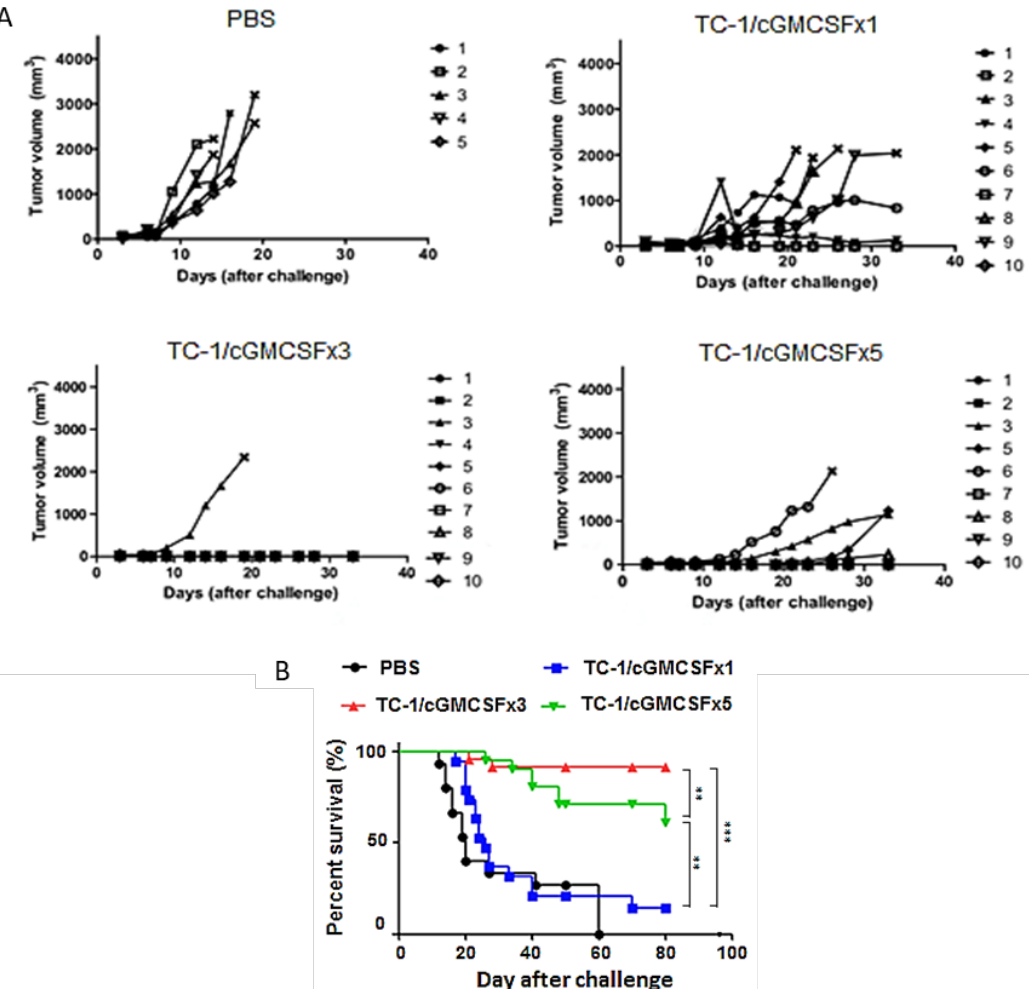
Figure 2. Tumor vaccination three times with cGM-CSF can more efficiently inhibit tumor growth compared with five-time vaccination. ( A ) C57BL/6 mice were injected with 1 × 10 6 irradiated TC-1/cGM-CSF subcutaneously at in the dorsal flank. Seven days after the last immunization, with a time interval of two weeks for multiple vaccinations, the mice were inoculated with 5 × 10 5 TC-1 cells subcutaneously at the right flank. The tumor size was monitored twice weekly for 6 weeks. The line graphs depict tumor volumes over time in various vaccinated mouse groups. The growth curve is shown in panel A. ( B ) Survival curve with mice vaccinated with PBS ( n = 15), one dose of irradiated TC-1/cGM-CSF vaccine ( n = 20), three doses of irradiated TC-1/cGM-CSF vaccine ( n = 23), and five doses of irradiated TC-1/cGM-CSF ( n = 23) vaccine. The log-rank (Mantel-Cox) test was used to compare the survival rates among various groups. ** p < 0.01, *** p < 0.001 (log-rank (Mantel-Cox)